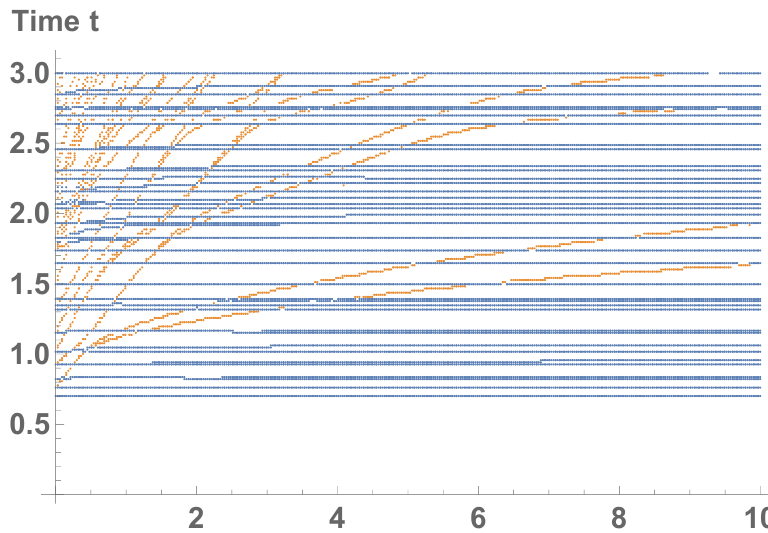
Figure 12 . The times of all conjugate points with the chaotic 3-body deformation δH 3 with N = 6 fermions. For ease of visibility, some of the easily distinguishable nonlocal conjugate points are highlighted in orange, while the blue lines correspond to µ -independent local conjugate